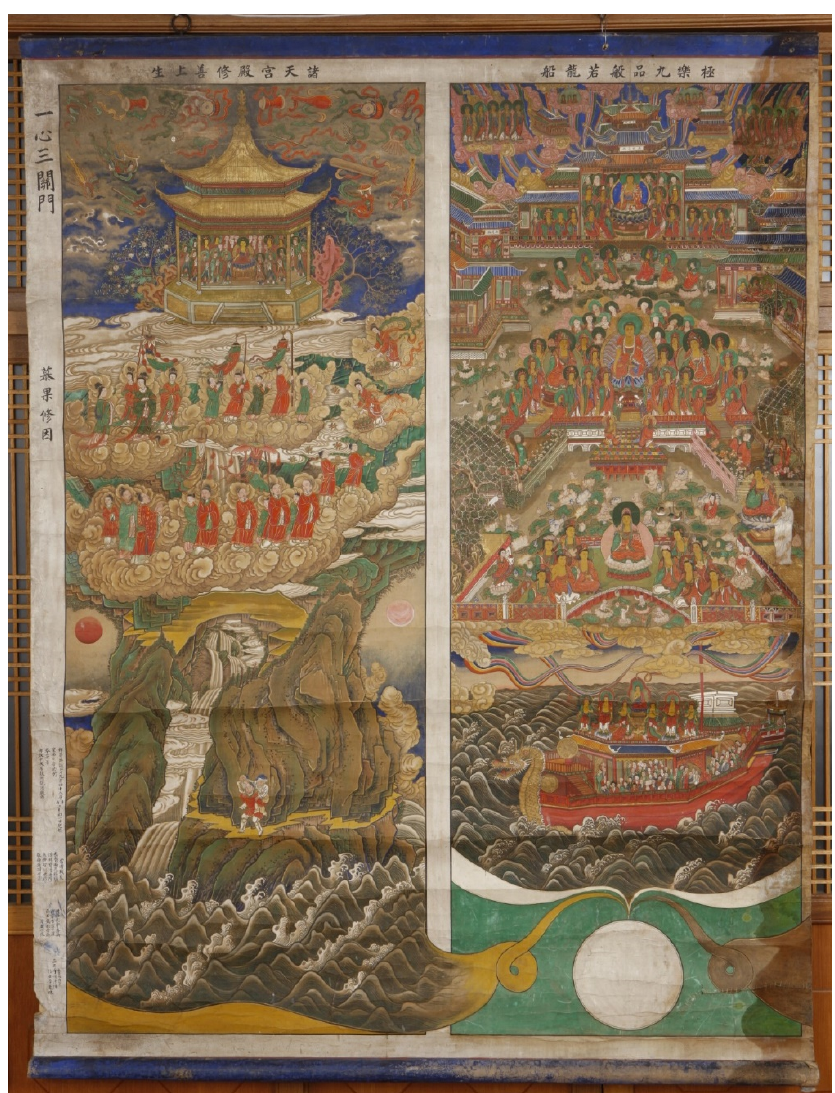
Figure 8. Ch’ukyŏn and others, Three Gates in a Single Mind . 1921. Colors on cotton, 217 × 161.5 cm. Simusa, Kŏch’ang, South Kyŏngsang Province. Photograph by Choi Yeub.